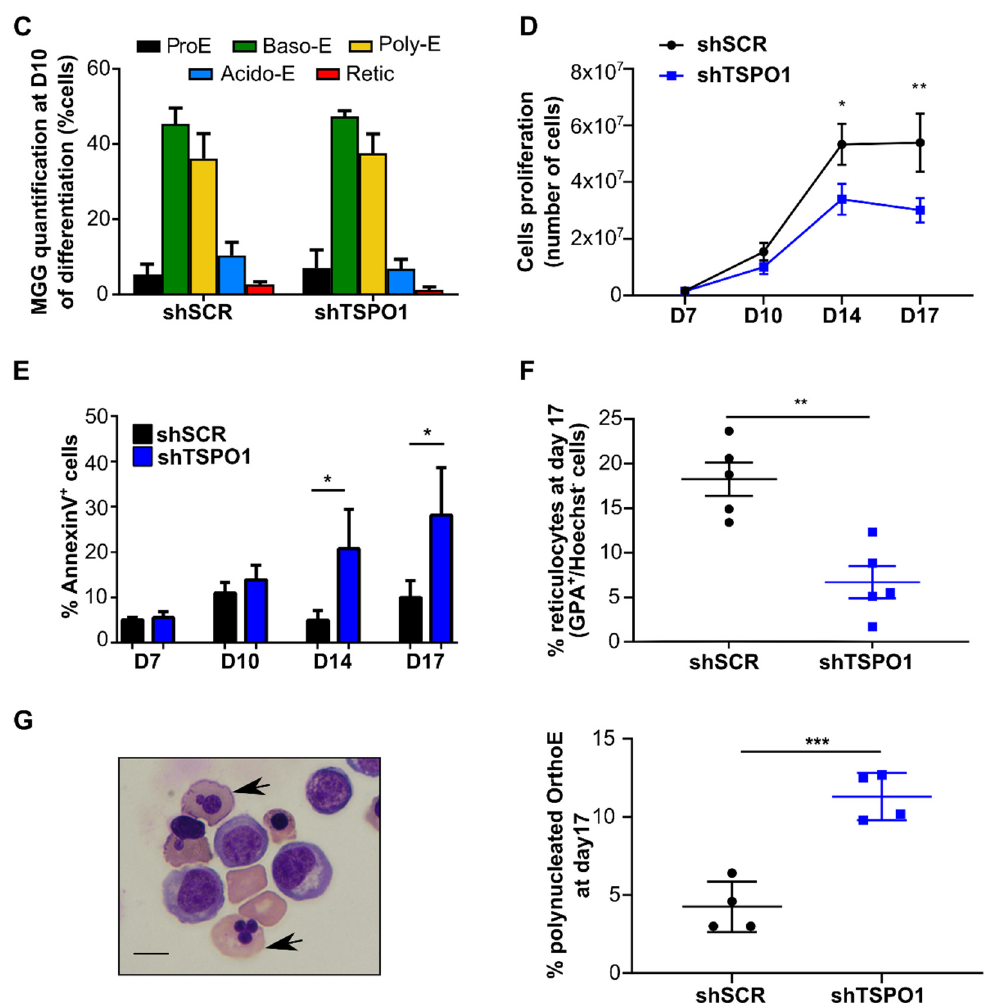
Figure 1. TSPO1 downregulation does not affect differentiation kinetics but diminished enucleation rate. ( A ) Schematic of the ex vivo erythroid differentiation protocol following shRNA-mediated downregulation of TSPO1 (CBMC, cord blood mononucleated cells; shSCR, scramble shRNA; shTSPO1, TSPO1 shRNA). CD34+ progenitors were isolated from cord blood and transduced at Day 4 with a lentiviral vector harboring either the TSPO1 shRNA or scramble shRNA, together with the green fluorescent protein (EGFP) transgene. EGFP+ cells were sorted at Day 7 and differentiated until Day 17. ( B ) Representative profile in flow cytometry of cells at Day 10 of erythropoiesis in scramble shRNA and TSPO1 shRNA. Glycophorin A positive (GPA+) cells are gated according to α 4-integrin and Band 3 expression levels to discriminate the different stages of differentiation. ( C ) May-Grünwald Giemsa (MGG)-based quantification at Day 10 of erythroid differentiation. ( D ) Erythroblast proliferation at Day 7, 10, 14, and 17 ( n = 4). ( E ) Apoptosis assay (annexin V) by flow cytometry at Day 7, Day 10, Day 14, and Day 17 ( n = 3). ( F ) Enucleated cells (GPA+/Hoechst- cells) were quantified by flow cytometry at Day 17 of differentiation ( n = 5). ( G ) Representative images (left) and quantification (right) of polynucleated Ortho-E (arrow) at Day 17 after MGG coloration ( n = 3). Scale bar = 20 μ m. * p < 0.05, ** p < 0.01, *** p < 0.001.